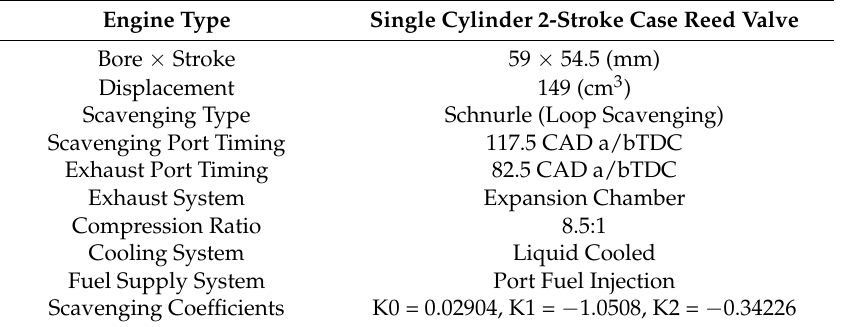
Table 1. Experimental engine specifications.